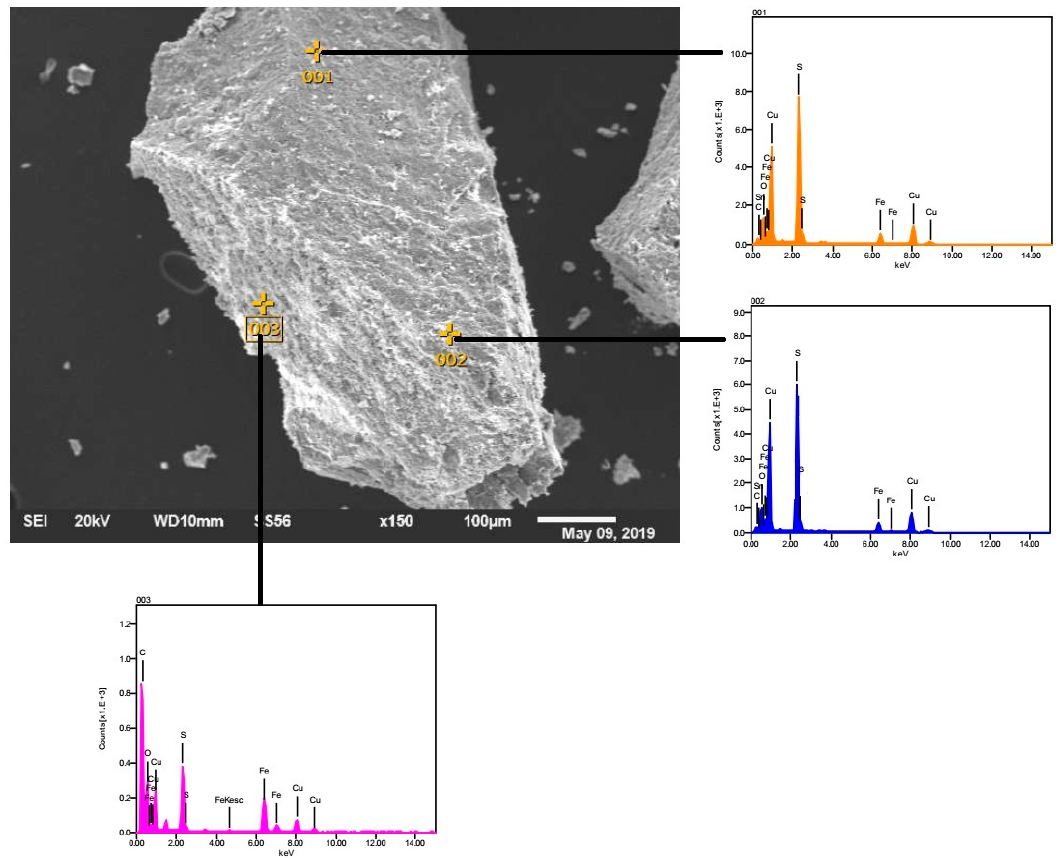
Figure 8. Scanning electron microscope–Energy dispersive X-ray spectroscopy (SEM-EDS) spectra of copper sulfide precipitate.